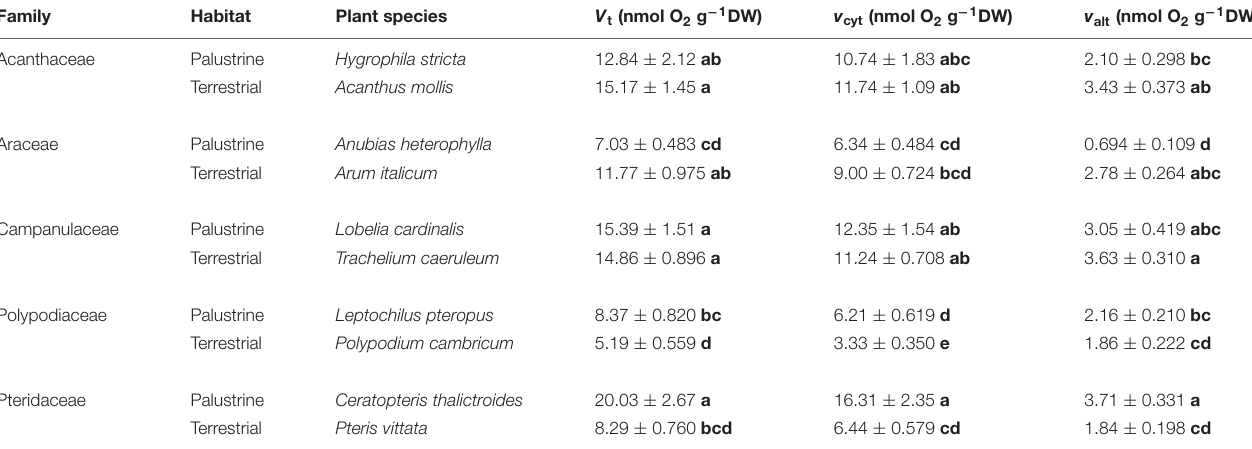
TABLE 4 | Total respiration ( V t ) and the in vivo activities of cytochrome oxidase ( v cyt ) and alternative oxidase ( v alt ) in aerial leaves of ten different terrestrial and palustrine plant species (see section “Materials and Methods”).